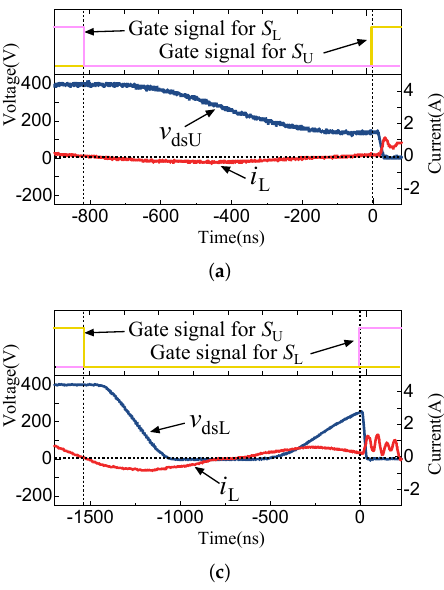
Figure 9. Zoomed waveforms around critical switching transients with the operating points outside of dead-time range for ZVS as example points, ( a ) marked as A, ( b ) marked as B, and ( c ) marked as C in Figure